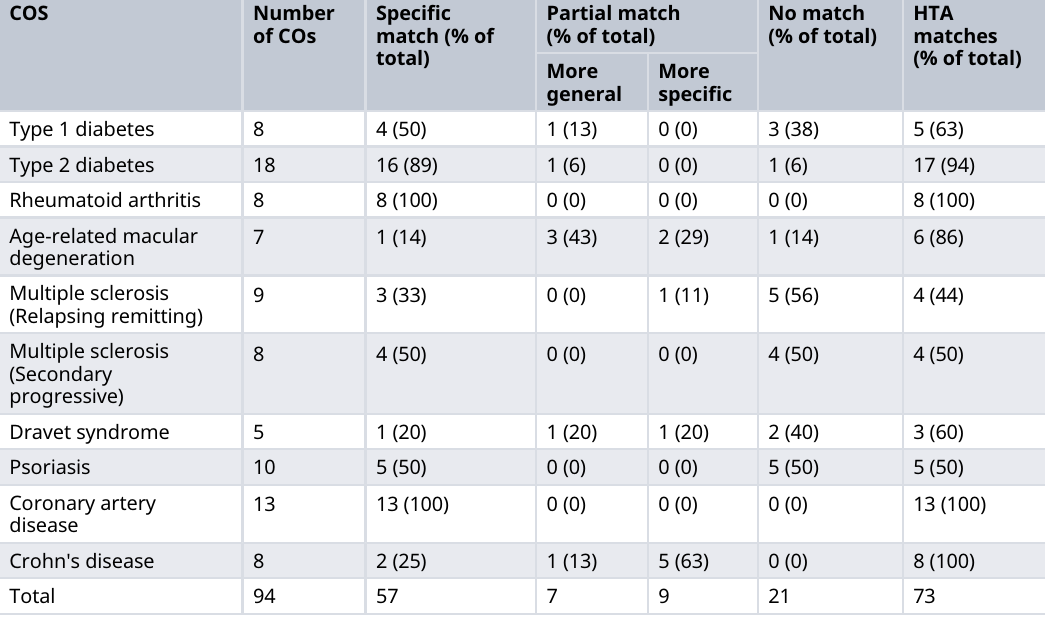
Table 6. Recently published non-oncology NICE HTAs compared with relevant COS, categorised as specific, partial or no match.